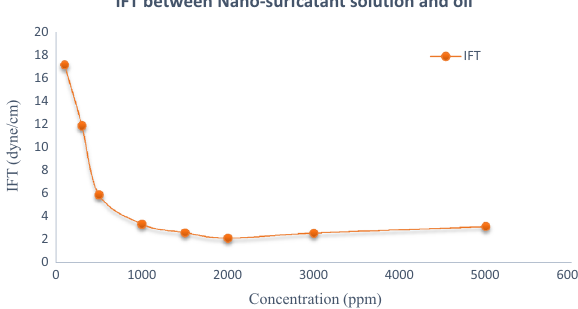
Fig. 8 IFT between oil/brine with 1000 ppm silica nanoparticle and various concentrations of